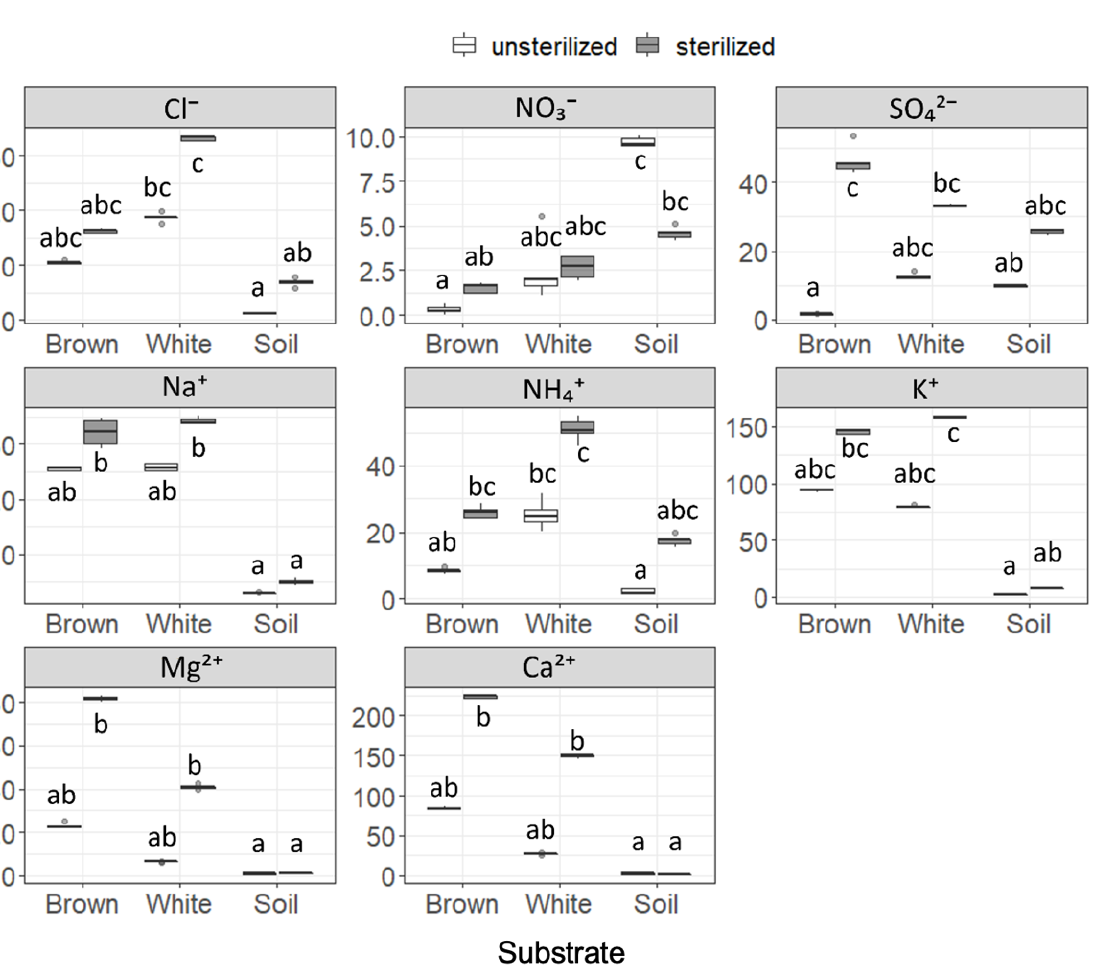
Figure 1. Nutrient ion concentrations in unsterilized and sterilized substrates (brown rot wood, white rot wood, and soil). Box plots display median, 95% confidence interval, and minimum and maximum values and points outside the box represent outliers. Different letters indicate significant difference among the six substrates ( p < 0.05, Brunner–Munzel test with Holm adjustment of probability values). n = 5.